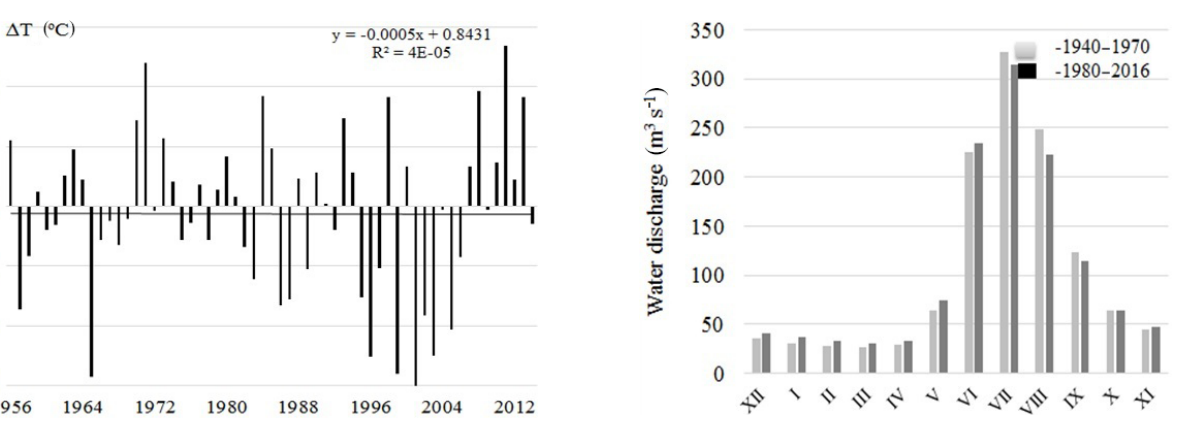
Figure 13. Hydrological regime of the Gunt River for the periods 1940–1970 and